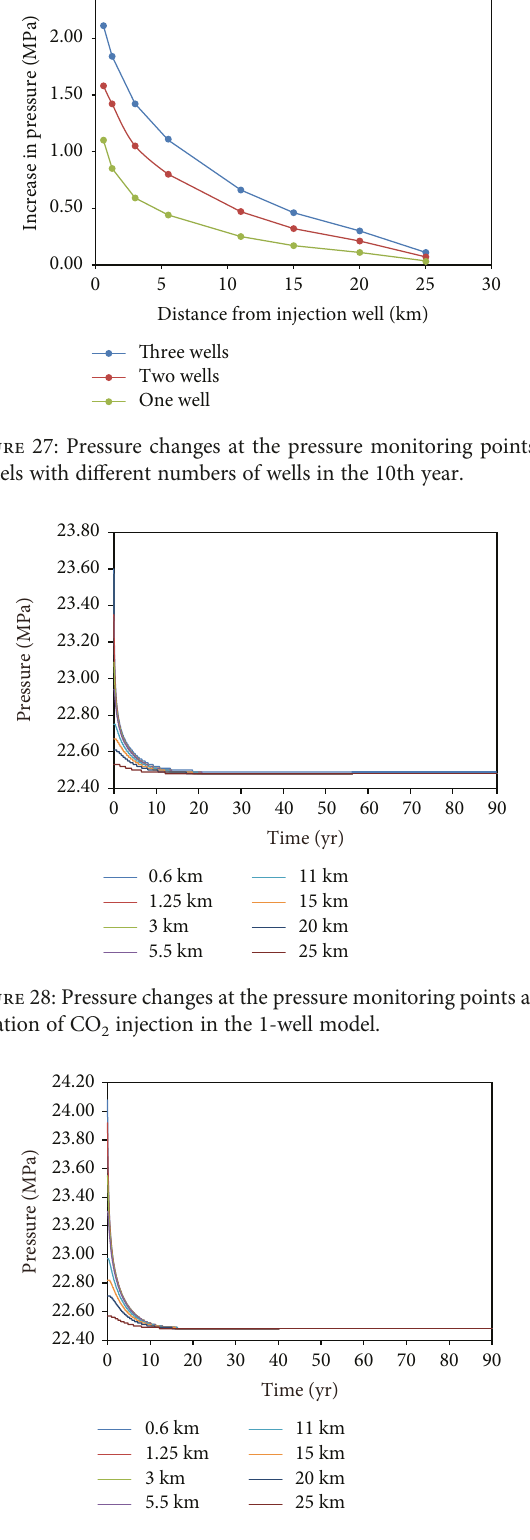
Figure 29: Pressure changes at the pressure monitoring points after cessation of CO injection in the 2-well model. 2